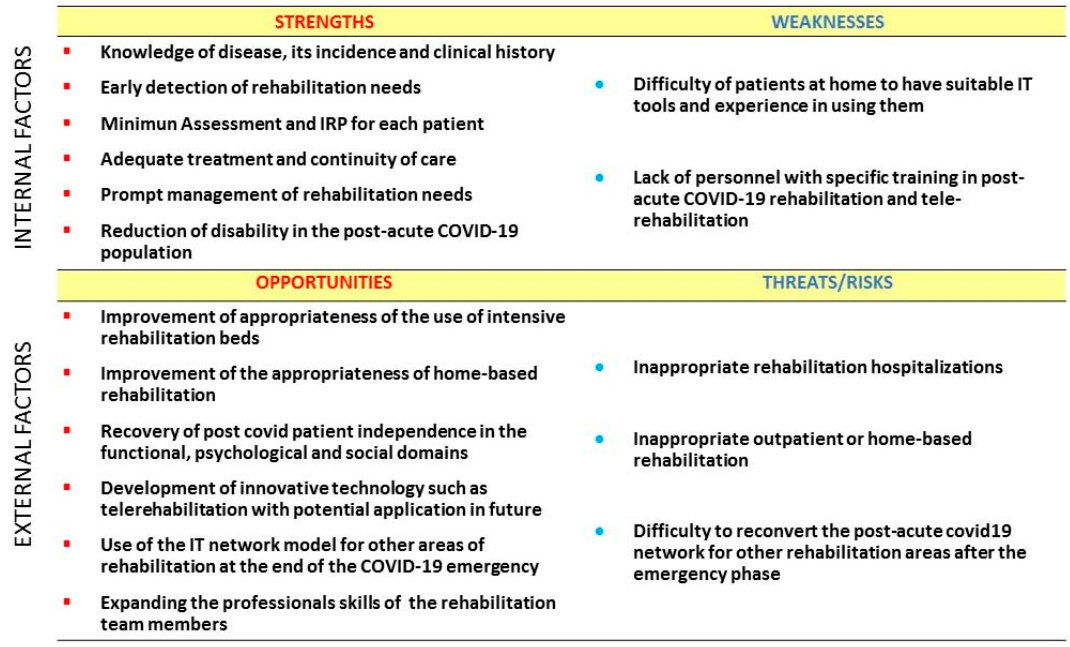
Figure 2. SWOT analysis of the post-acute COVID-19 rehabilitation network model.